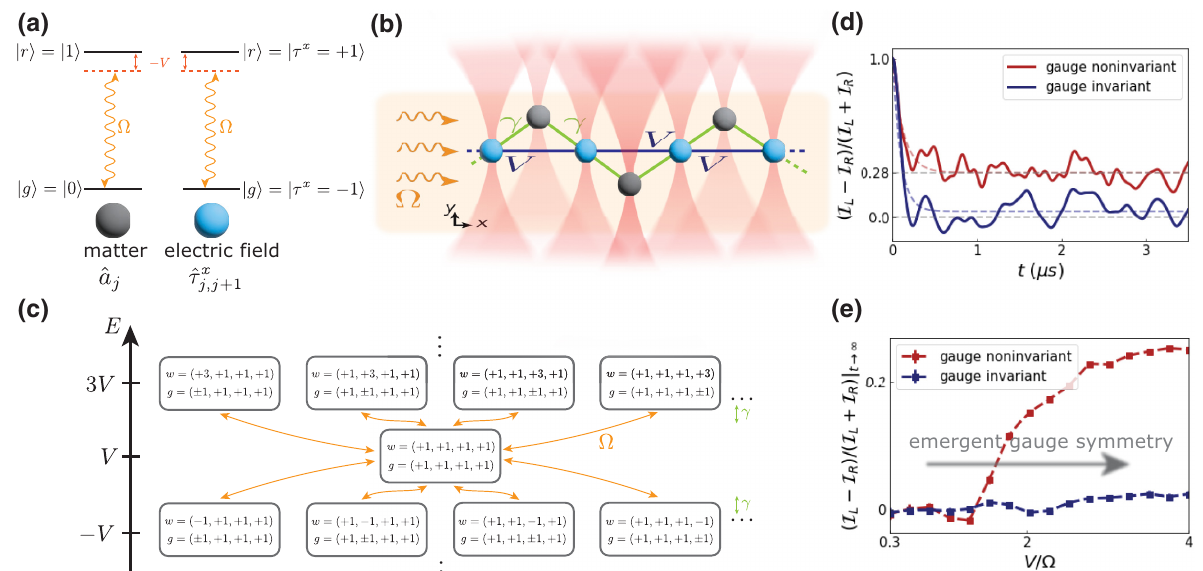
FIG. 8. (a) The matter and gauge degrees of freedom can be mapped onto qubits, where the two energy levels are, e.g., given by the ground and Rydberg states in an ultracold-atom setup. Likewise, superconducting qubits can also be used in our experimental proposal. Here, gray (red) circles depict the matter (electric) fields on the sites (links) of the one-dimensional lattice. The qubits have to be driven at strength (cid:12) and detuning V . We note that the detuning is chosen to have the same strength as the LPG protection. (b) In the case of atomic tweezer arrays, the density-density interaction can be controlled by the interatomic distance r and scales as r − 6 . The shown setup is a possible configuration to implement Hamiltonian (15). In our proposal, we require V = 2 / 3 γ . (c) The LPG protection terms ∝ γ stabilize the system against errors, where two sectors ∝ V separate the different ˆ W j sectors energetically. Furthermore, the terms are lifted up and down in energy. The drive (cid:12) couples between different sectors and hence induces the desired dynamics within the energy sectors in higher-order perturbation theory. (d) We plot the raw (temporally nonaveraged) imbalance for different initial states (cid:3) shows a (solid lines) and fit the result with an exponential function (dashed lines). The gauge-noninvariant superposition state | ψ z 0 prethermal localizing behavior that is distinctly different from the thermalization of the gauge-invariant initial state to zero imbalance. We use experimentally realistic parameters γ = 2 π × 4.5 MHz, V = 2 π × 3 MHz, and (cid:12) = 2 π × 1 MHz, which leads to interesting dynamics within experimentally feasible timescales of approximately 3 μ s. (e) As in (d), we fit the imbalance for different driving strengths V /(cid:12) and extract the t → ∞ value. We find two different regimes with and without disorder-free localization that emphasize the emergent gauge symmetry in the limit of weak driving V /(cid:12) (cid:2)